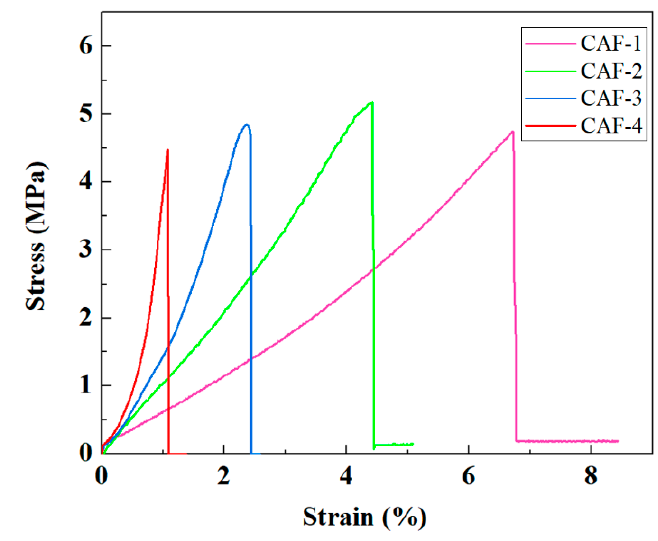
Figure 5. Stress–strain curves of CAFs.